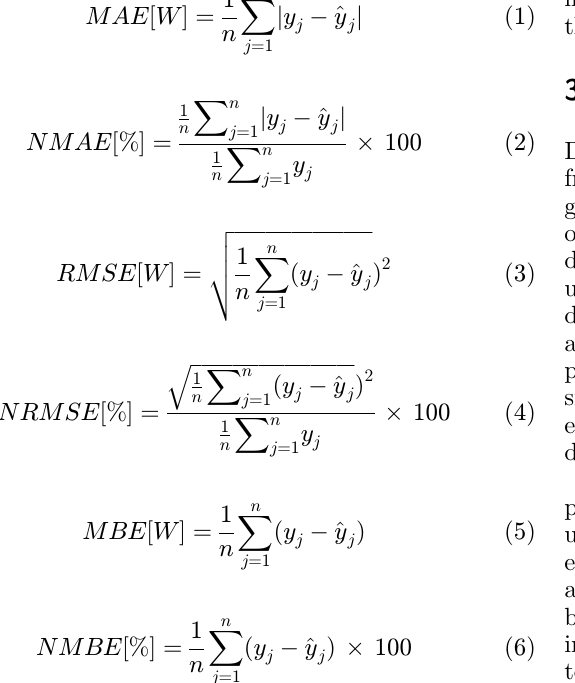
ffiffiffiffiffiffiffiffiffiffiffiffiffiffiffiffiffiffiffiffiffiffiffiffiffiffiffi